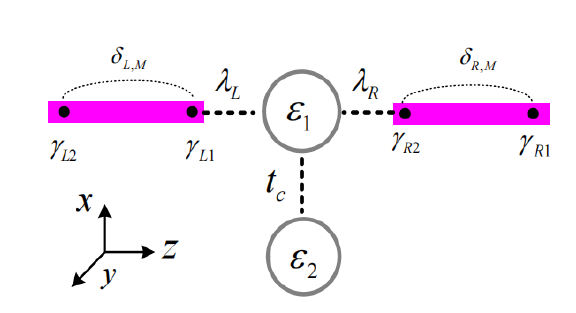
Figure 1. (Color online) Schematic plot of the studied system composed of T-shaped double quantum dots sandwiched between two nanowires hosting Majorana bound states on their ends. The coupling strengths between the central dot and the left/right Majorana bound states are denoted by λ L / R . Due to the substrate superconductors of the nanowires, different phase factors arise in λ L / R . Here we consider symmetrical phase difference ∆ φ and define λ L / R = λ 0 e ± i ∆ φ /2 . The central and the side-coupled dots are tunnel-coupled to each other with strength of t c , and individually have discrete energy levels of ε 1 and ε 2